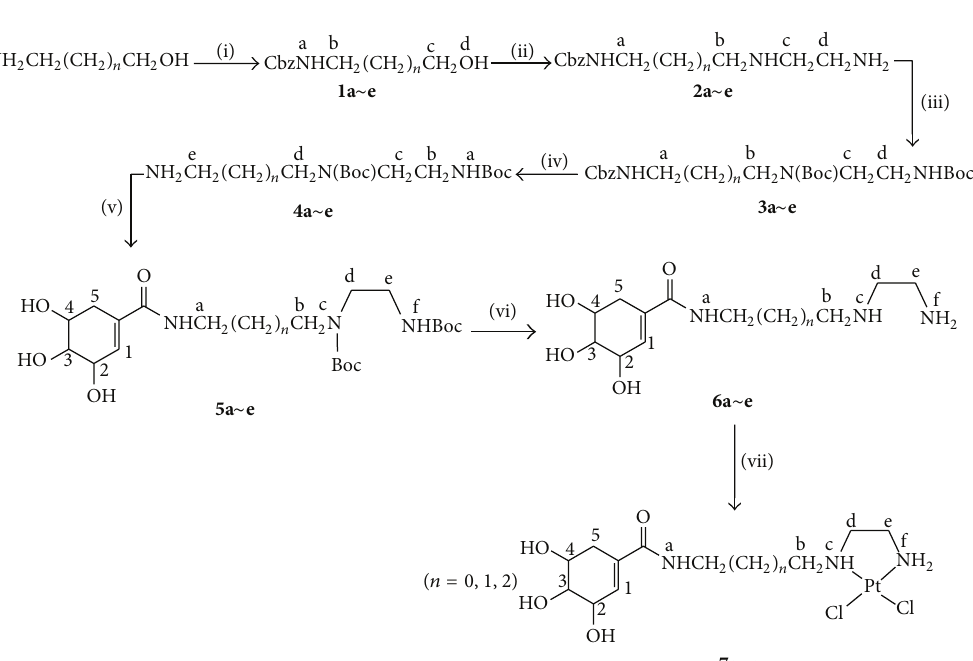
Scheme 1: Synthesis route for the shikimic acid derivate ligands and Pt(II) complexes ( 𝑛 = 2 , 3, 4, 5, 6): (i) CbzCl, NaHCO 3 , H 2